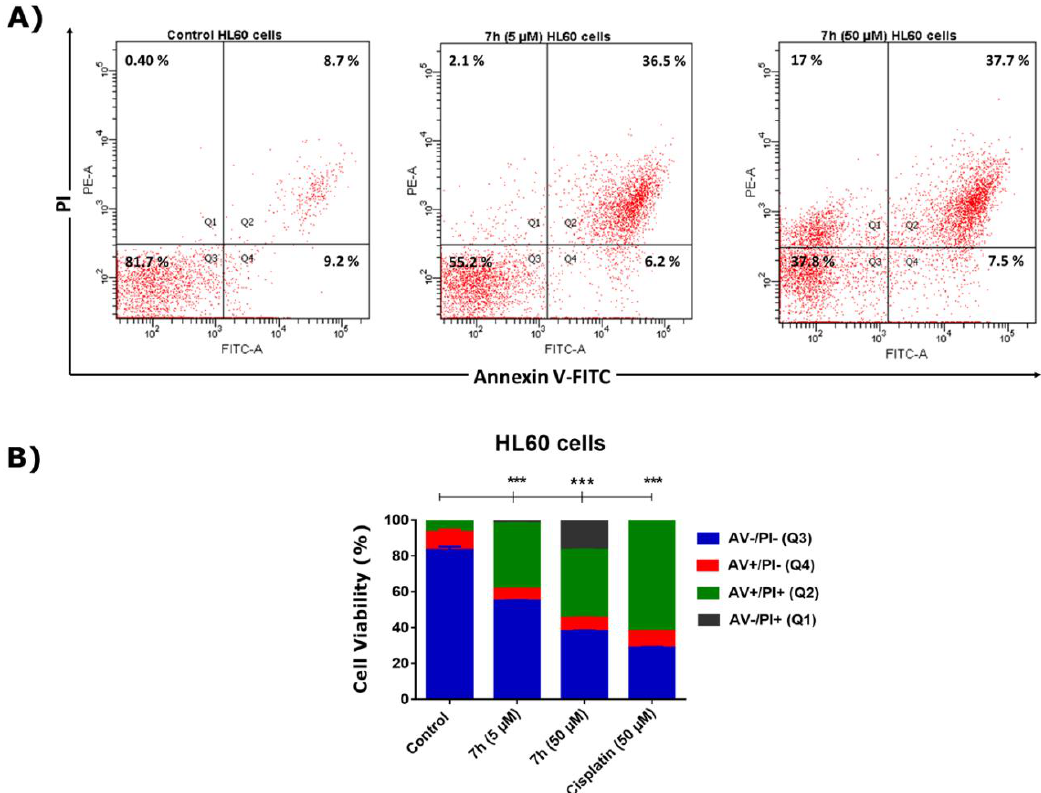
Figure 8. Flow cytometry analysis of dead cell apoptosis assessed by Kit annexin-V FITC / PI Alexa Fluor 488. ( A ) Representative dot plot of HL-60 cells untreated (control) or treated for 24 h with 5.0 and 50 µ M concentration for 7h . ( B ) Graphical representation after quantification of the percentage of cells in each quadrant of the dot plot with 5.0 and 50 µ M concentrations. Results were obtained using the non-treated cells as control and average ± SD of two independent experiments. We analyzed annexin-V FITC / PI data by one-way ANOVA non-parametric Dunnett test. * p < 0.001.